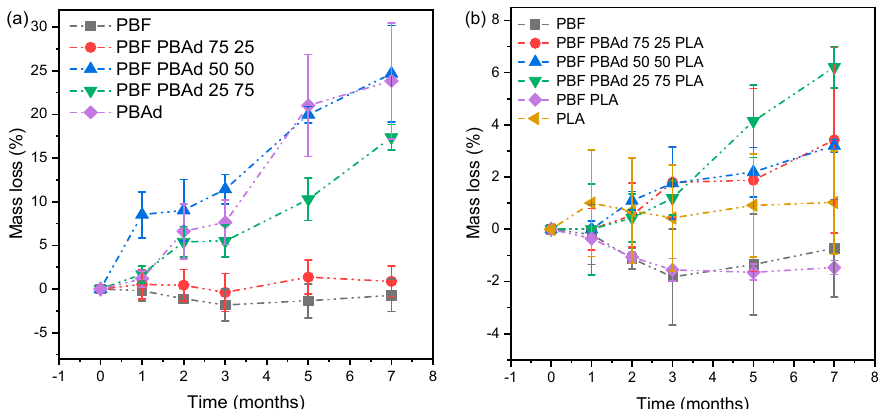
Figure 7. Water contact angle of the polymers before and after blending.